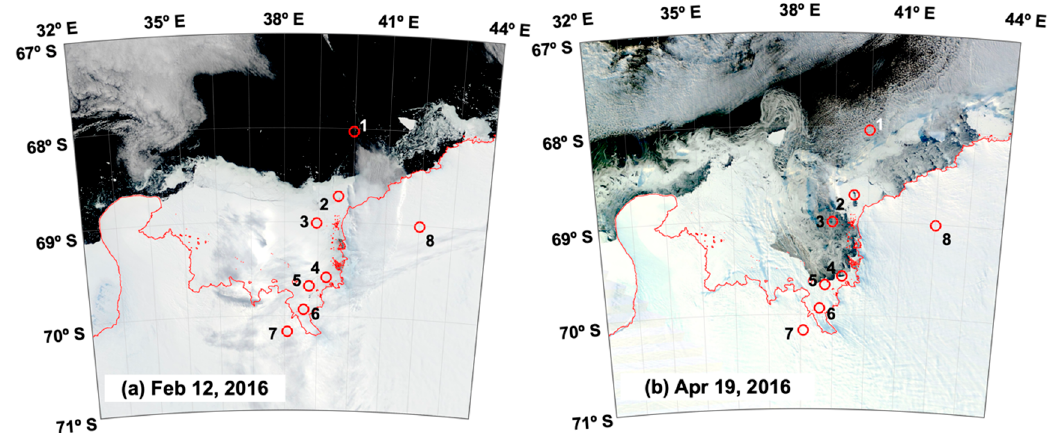
Figure 2. Time series of the spatial distribution of sea ice based on MODIS imagery for ( a ) February 12, and ( b ) April 21 in 2016.